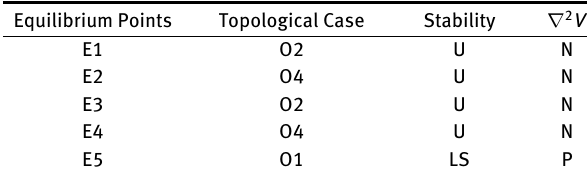
Table 3. The topological property and stability of the equilibrium points. LS: linearly stable; U: unstable; P: positive definite; N: non- positive